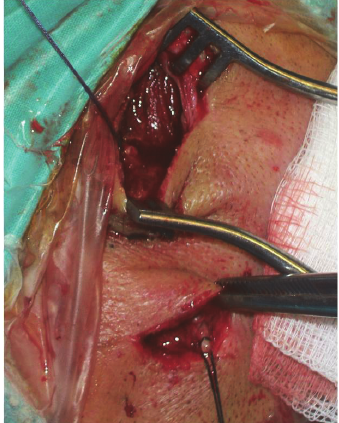
Figure 5: Proximal and distal control of the temporal artery and excision of the